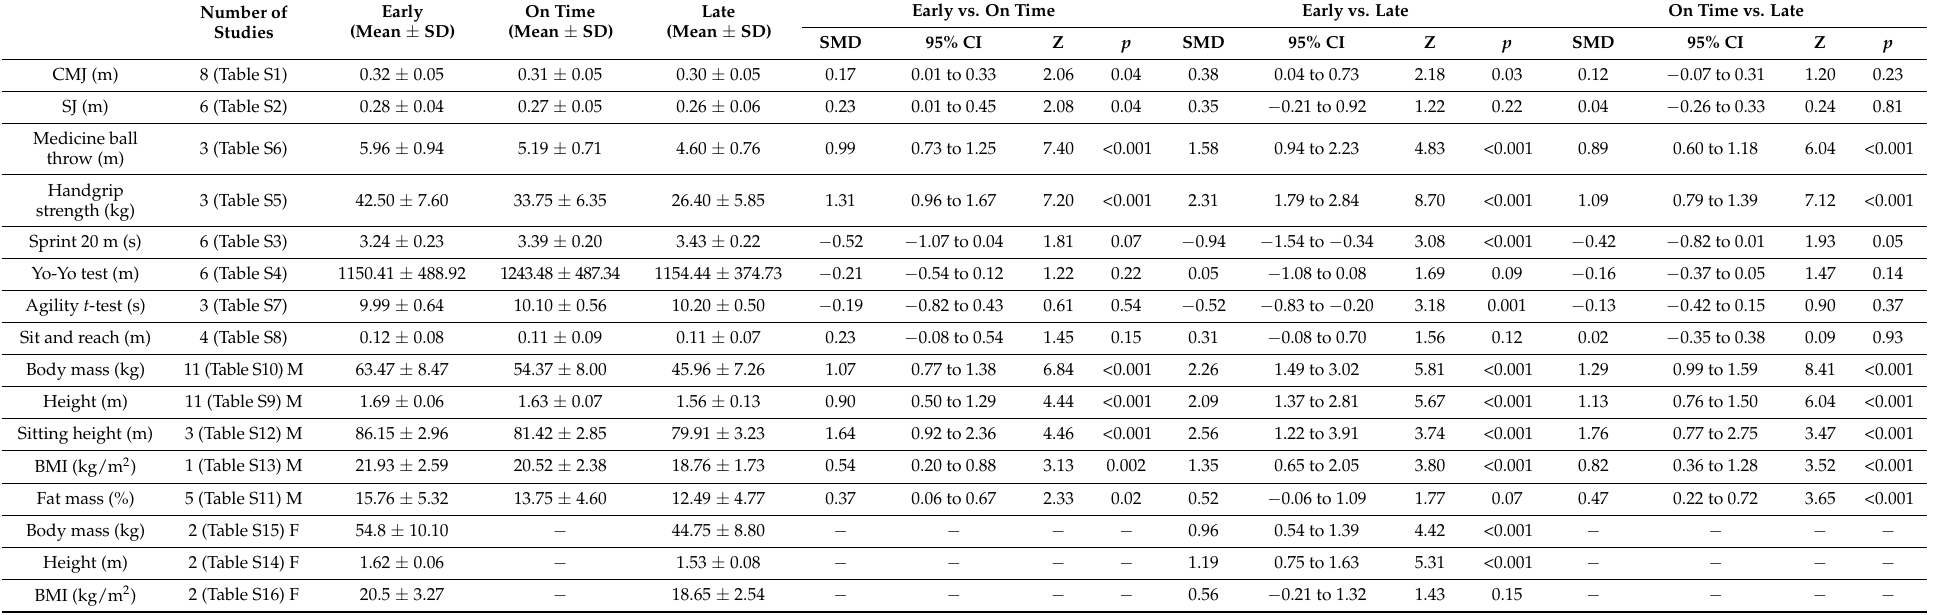
Table 3. Means and statistical differences between groups in physical fitness tests and kinanthropometric